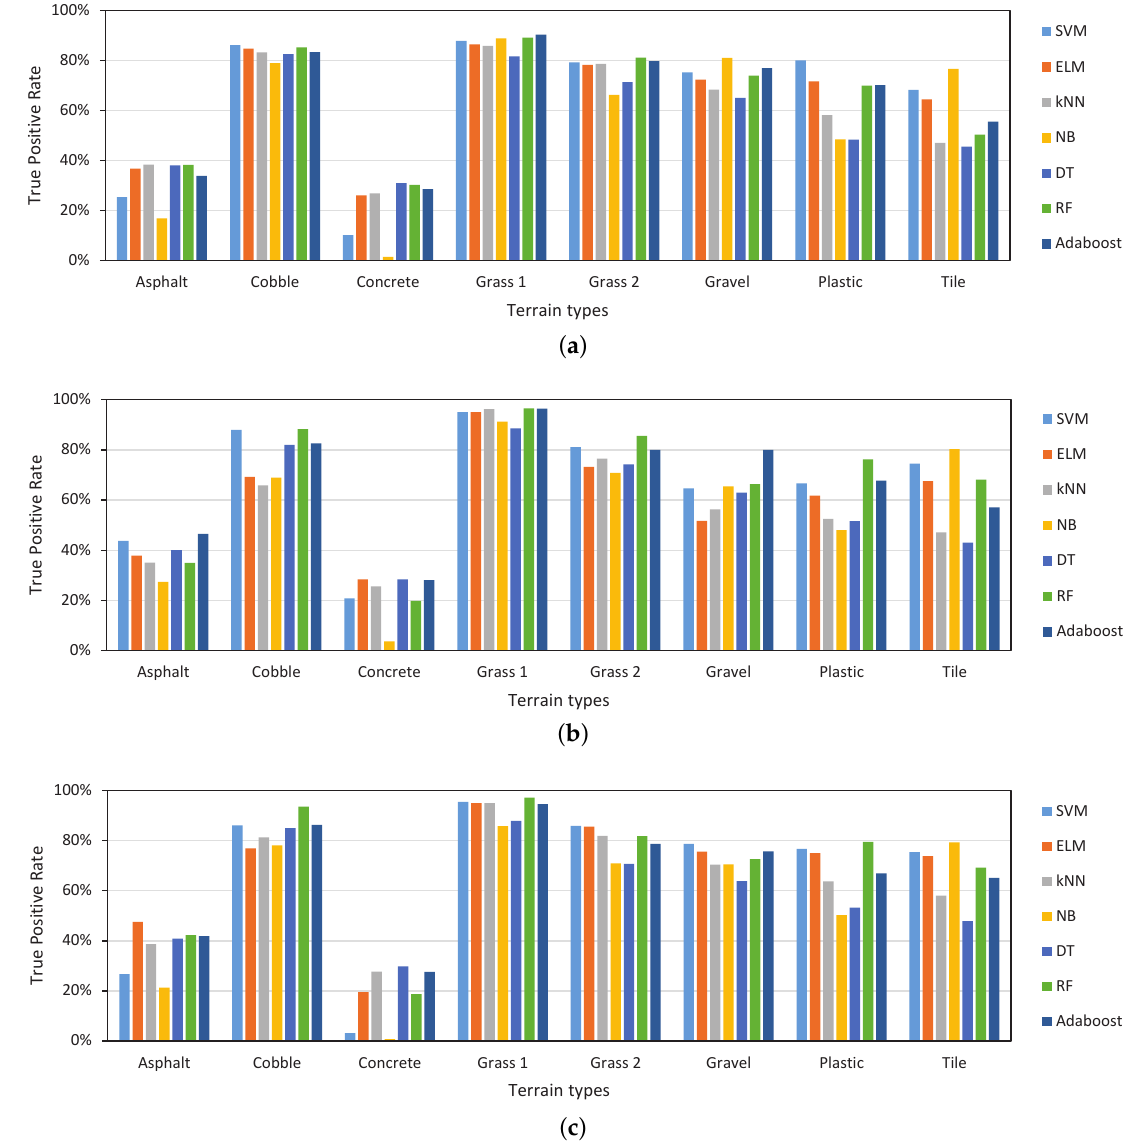
Figure 6. True positive rate for 8 terrain types with different classifiers using ( a ) Time-domain features, ( b ) FFT-based features, ( c ) PSD-based